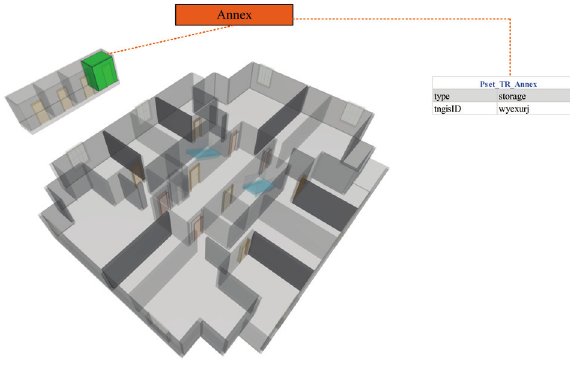
Figure 5. Modelled annex.